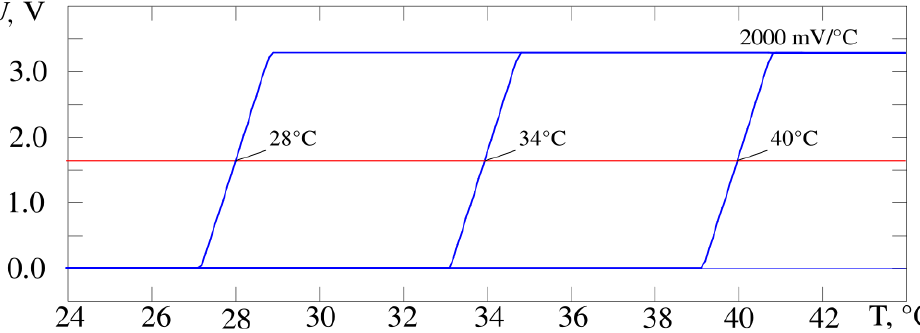
Figure 6. The output characteristics of the thermometer circuit (blue curves) from Figure 4, operating point temperature is changed by 12 °C. The operating point voltage passes at the level of the middle of dynamic range at the level of 1.64 V (red line).